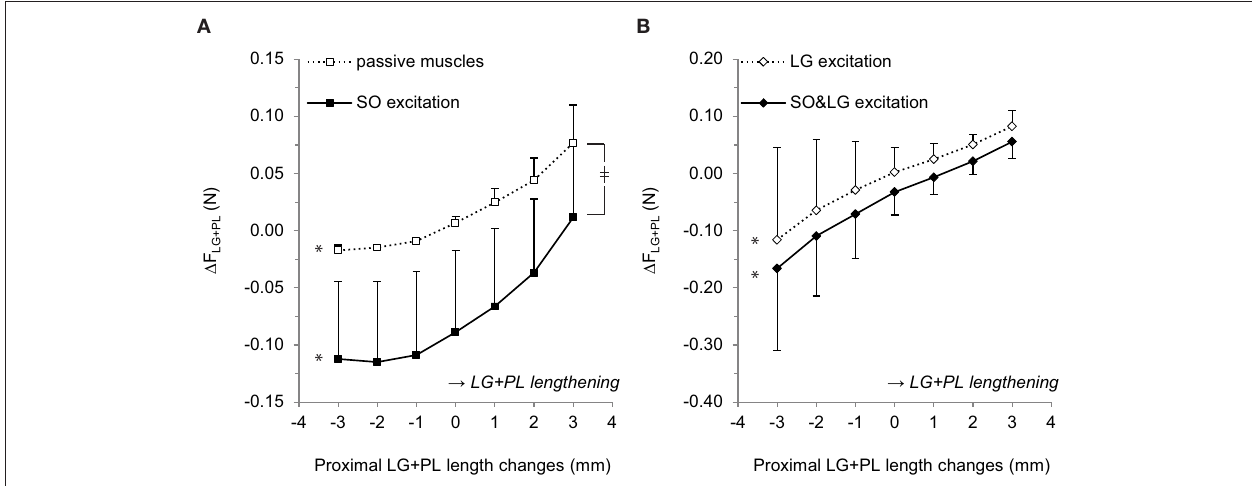
FIGURE 4 | Effects of proximal LG + PL length changes on the difference between force exerted at the proximal and distal LG + PL tendons ( 1 F LG+PL ). (A) 1 F LG + PL for passive SO and LG muscles ( (cid:3) ) and for active SO only ( (cid:4) ). (B) 1 F LG + PL for active LG only ( ♦ ) and for active SO and LG ( (cid:7) ). Negative values of 1 F < F LG + PL indicate F LG + PL_PROX LG + PL_DIST . Means ± s.d. are shown ( n = 5). Significant effects of LG + PL length are indicated as * p ≤ 0.05. Significant interaction effects between muscle excitation and LG + PL length are indicated as ‡ p ≤